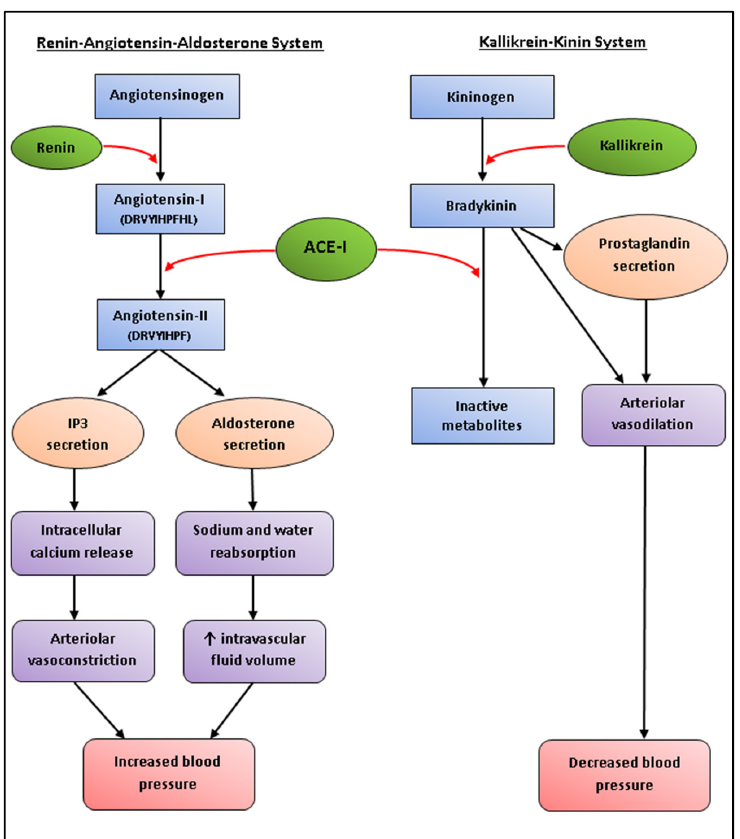
Figure 2. Schematic representation of the renin–angiotensin–aldosterone system (RAAS) and the hypertensive effect of angiotensin ‐ I ‐ converting enzyme (ACE ‐ I). Angiotensinogen is converted to the